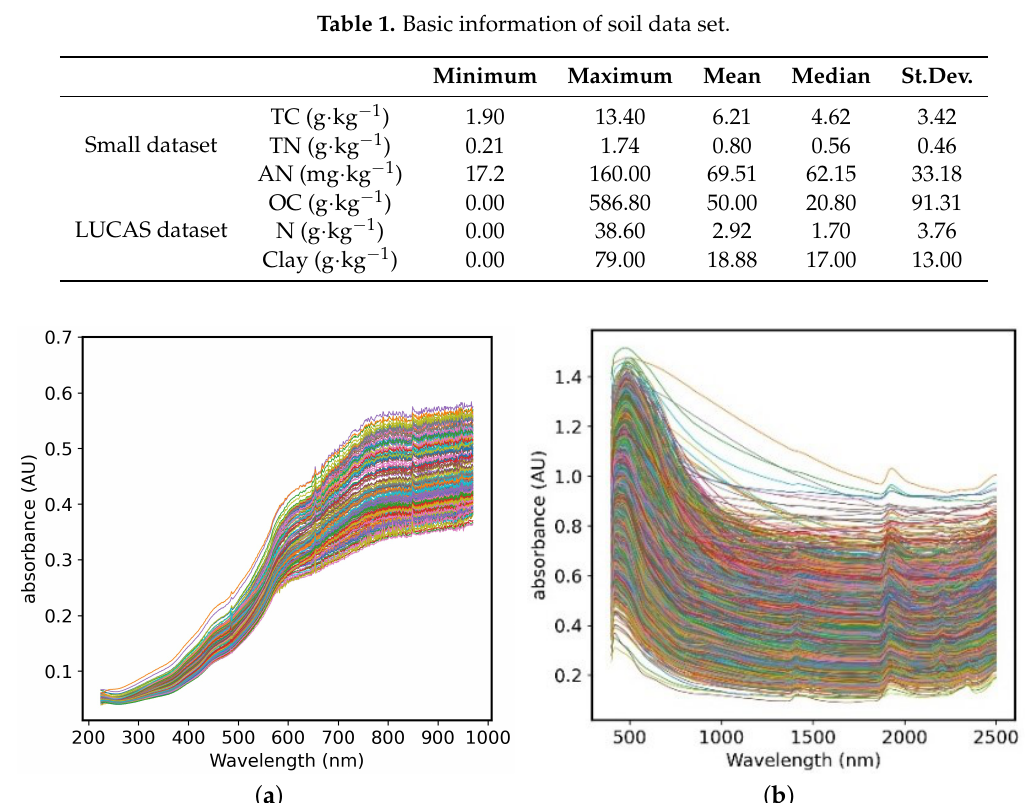
Figure 1. Original spectrogram of ( a ) Small dataset ( b ) LUCAS